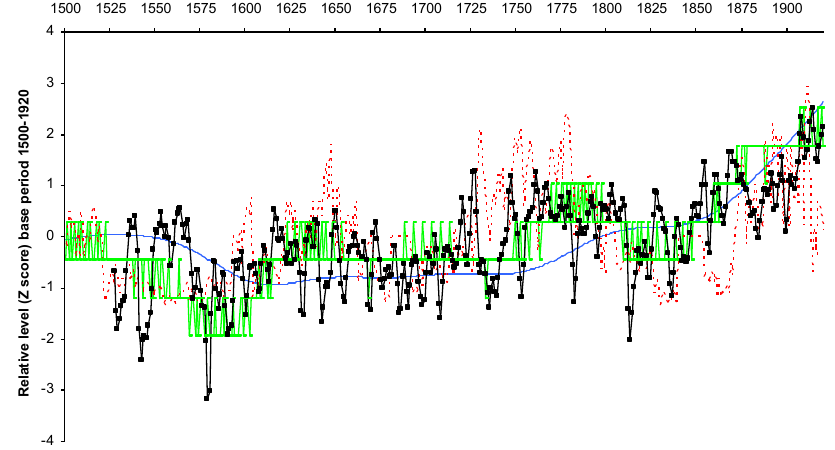
Figure 9. Z -scored annual data: paleoclimate time series from 1500: ice core level of CO 2 (blue curve), level of CO 2 transformed into first-difference form (green barred curve); and temperature from speleothem (red dashed curve) and tree ring data (black boxed curve).